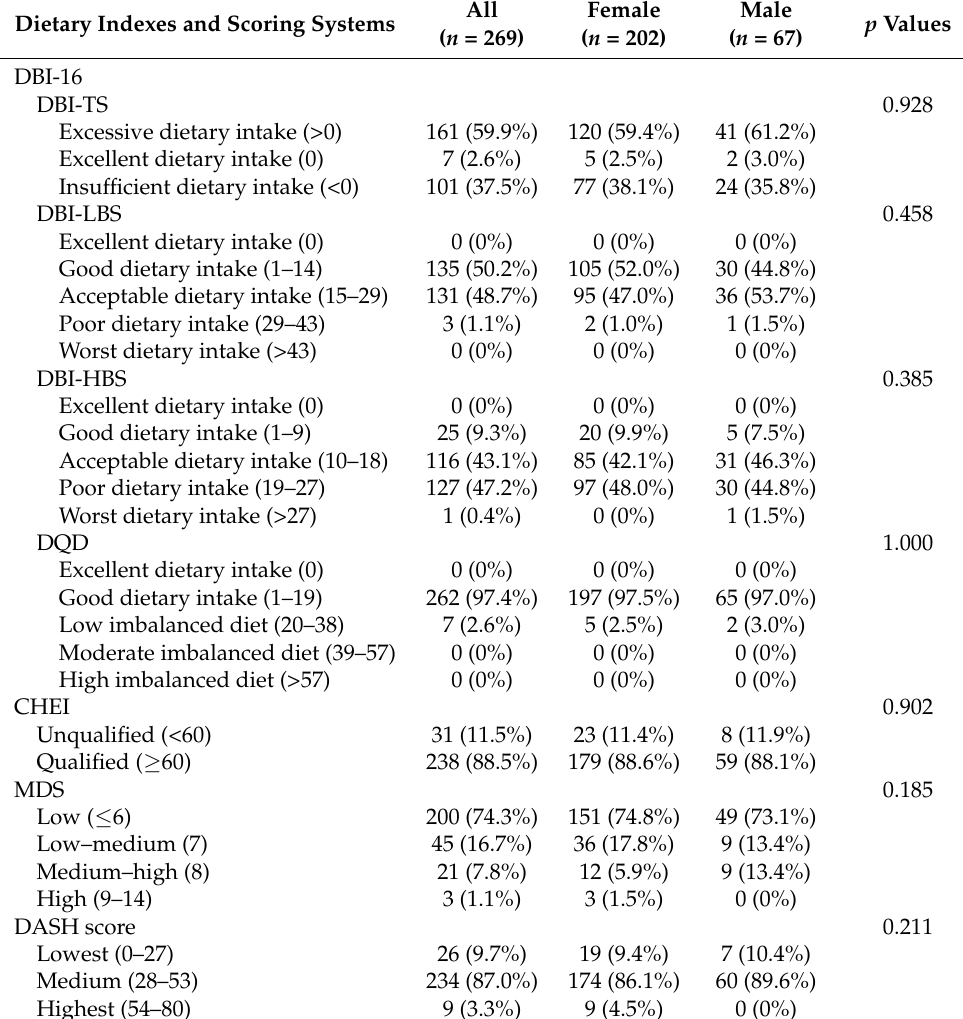
Table 4. Distribution of a priori dietary index scores among 269 Chinese participants with hyperlipi- demia according to gender 1,2